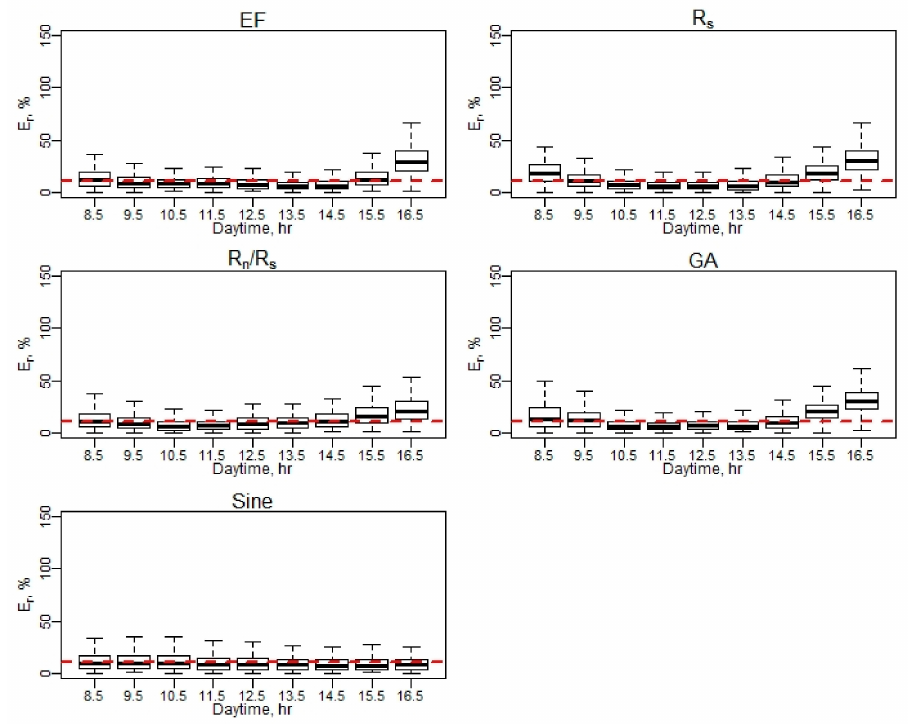
Figure A16. E r of daily EC ET